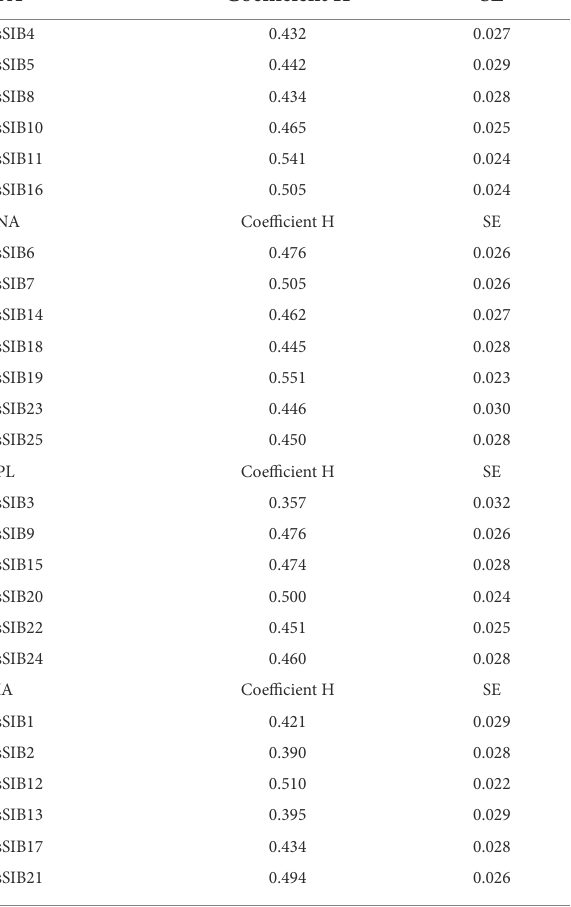
TABLE 6 Coefficients of item scalability for s-SIB performance. TABLE 7 Slovak norms for s-SIB distress and